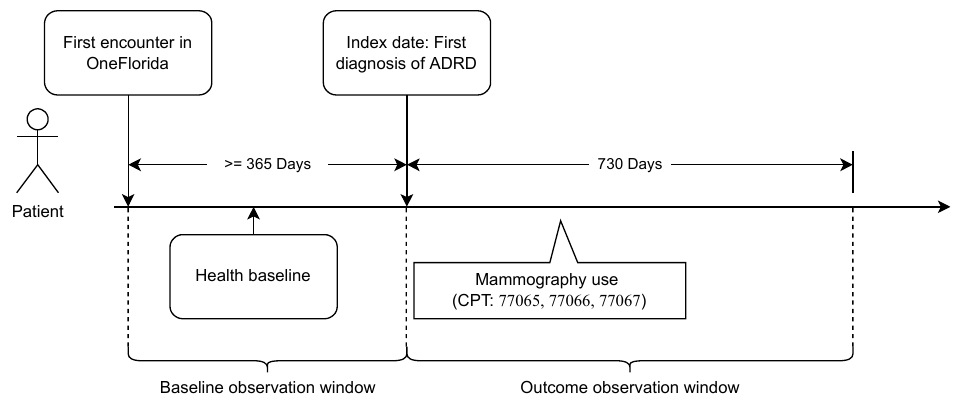
Figure 1. Index date and observation window for the study population.